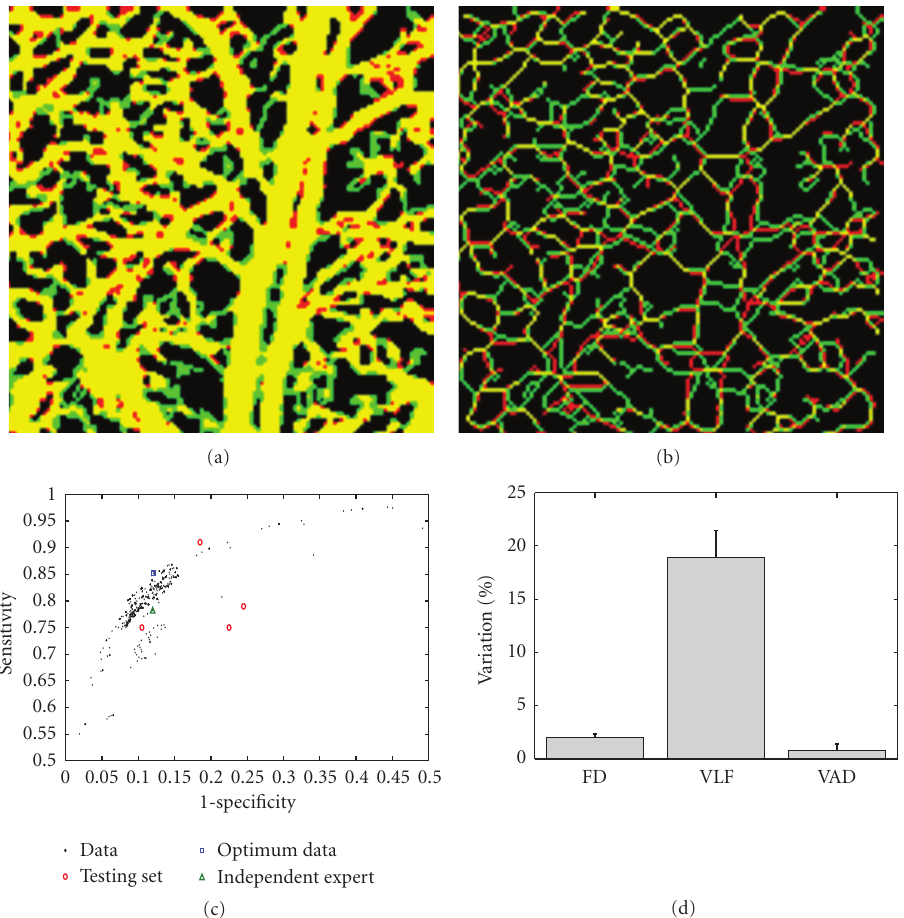
Figure 4: (a) Overlay of the GS image with the optimum automatically segmented image. (b) Overlay of the skeletonized GS image with the optimum automatically segmented skeleton image. (c) ROC curve of the automatically segmented image using a combination of 1000 di ff erent variables V1, V2, and V3. (d) Mean and standard deviation of the percent variation of the FD, VLF, and VAD between the manually and automatically segmented five test